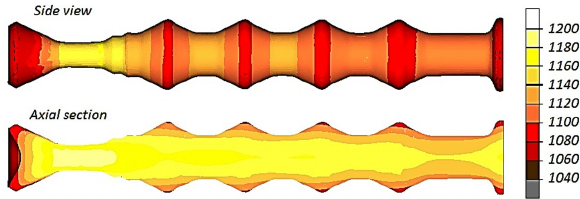
Figure 7: Distribution of the temperature (in °C) in the preform pro- duced by skew